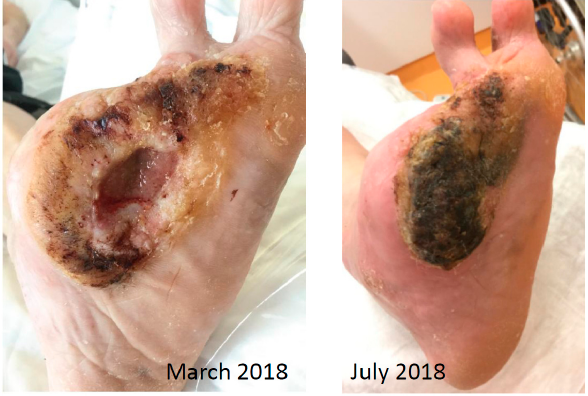
Figure 3. Clinical findings in patient 1.